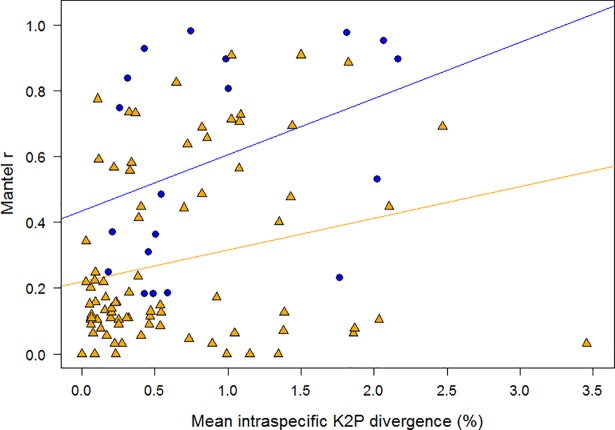
Relationship of intraspecific sequence divergence and geographic distance.Relationship between mean overall intraspecific sequence divergence and the extent of isolation by distance (as quantified by the Mantel correlation coefficient, r), with species patitioned according to their type of distribution. Species with disjunct distributions (blue circles) tended to show stronger isolation-by-distance (i.e. higher r values) than species with continuous distributions (orange triangles), and this pattern was marginally stronger in species with higher overall levels of intraspecific sequence divergence.